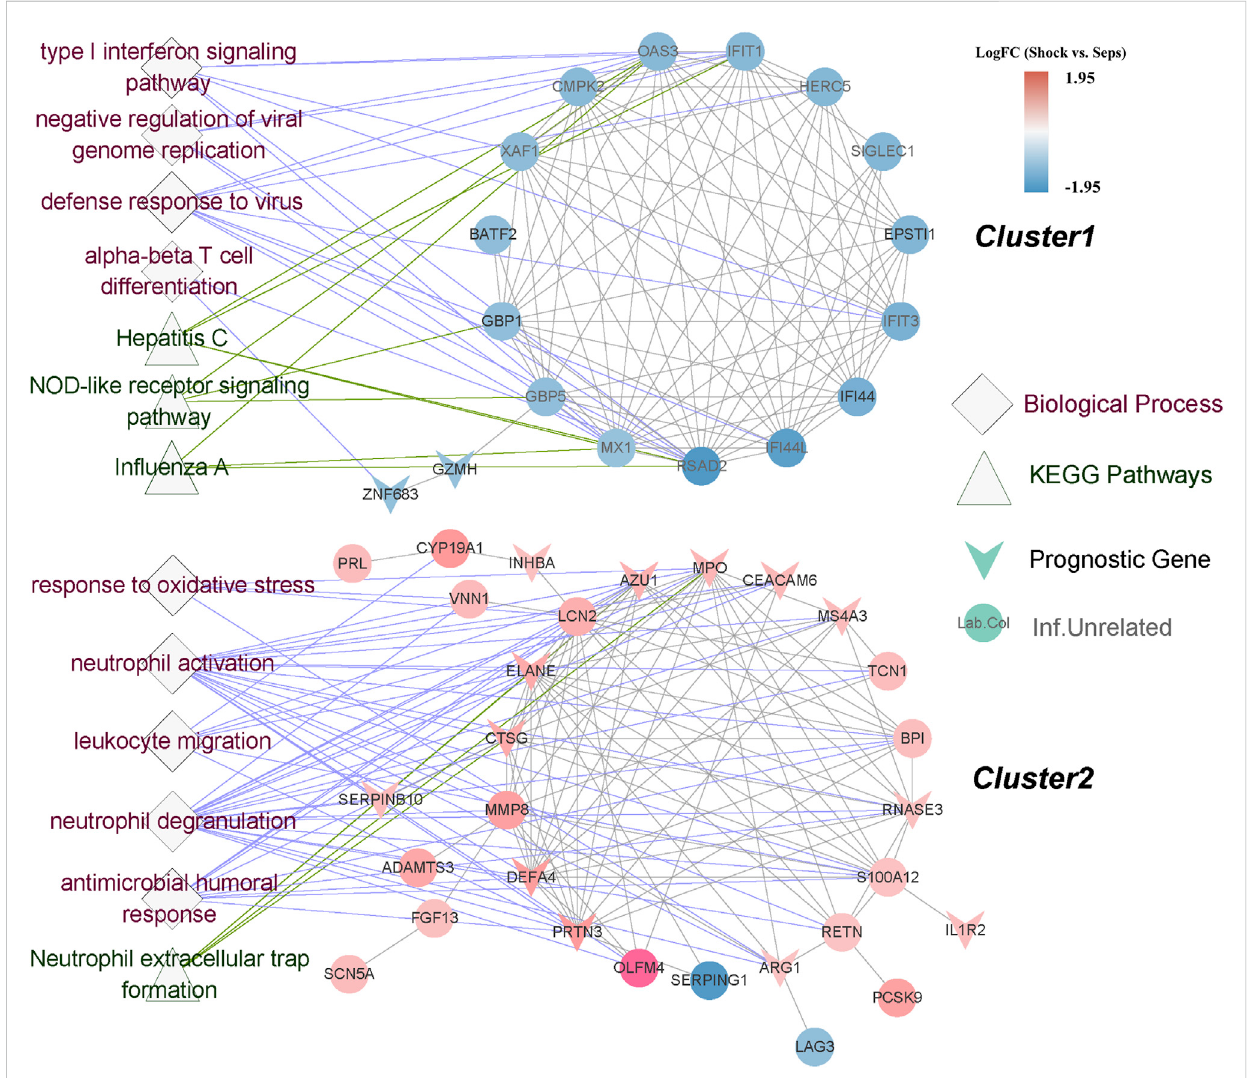
PPInetworkconstructionandover-representationanalysisofclustergenes.PPInetworkconstructedbySSAGsfromSTRINGdatabase,wereclearly divided into 2 clusters. The color of gene nodes indicated log2 fold change. V-shape represented the prognostic genes. The diamond shaped nodes and the triangle shaped nodes represented enriched biological processes and KEGG pathways